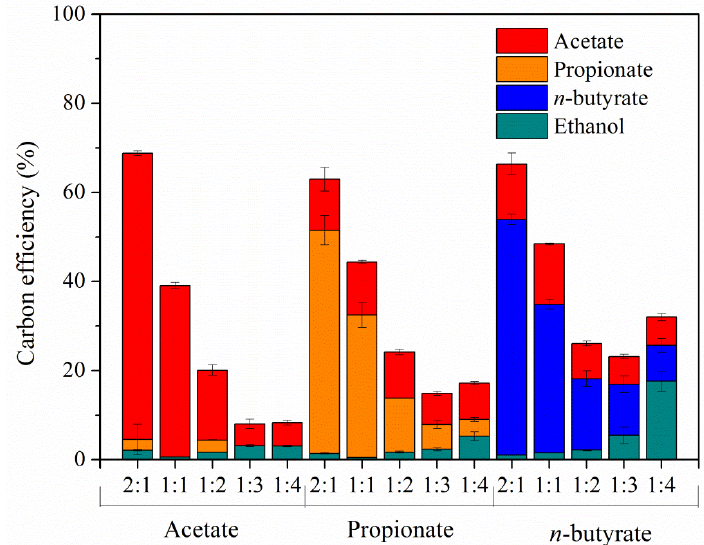
Figure 9. Specific residual organic efficiency at different acid/ethanol ratios with acetate, propionate, and n-butyrate as the electron acceptor (Residual carbon efficiency equal to the sum of each residual organic efficiency in the chain elongation system).